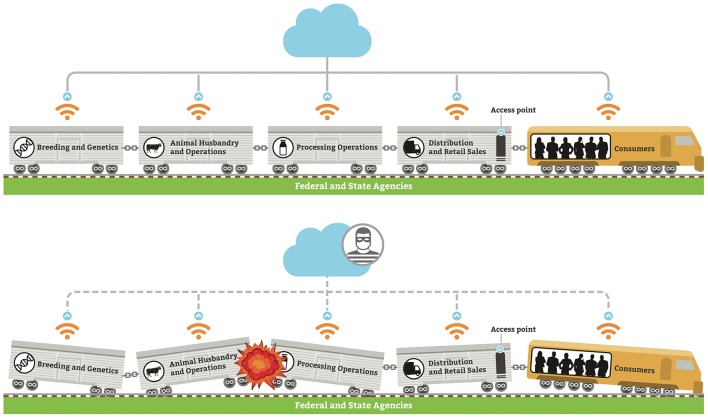
(Top) Fd+Ag system for each commodity sector is a sequence of stages, with limited communications and sharing of data between each; (bottom) if a cyber-biosecurity event occurs, it can have catastrophic effect on the entire Fd+Ag system.